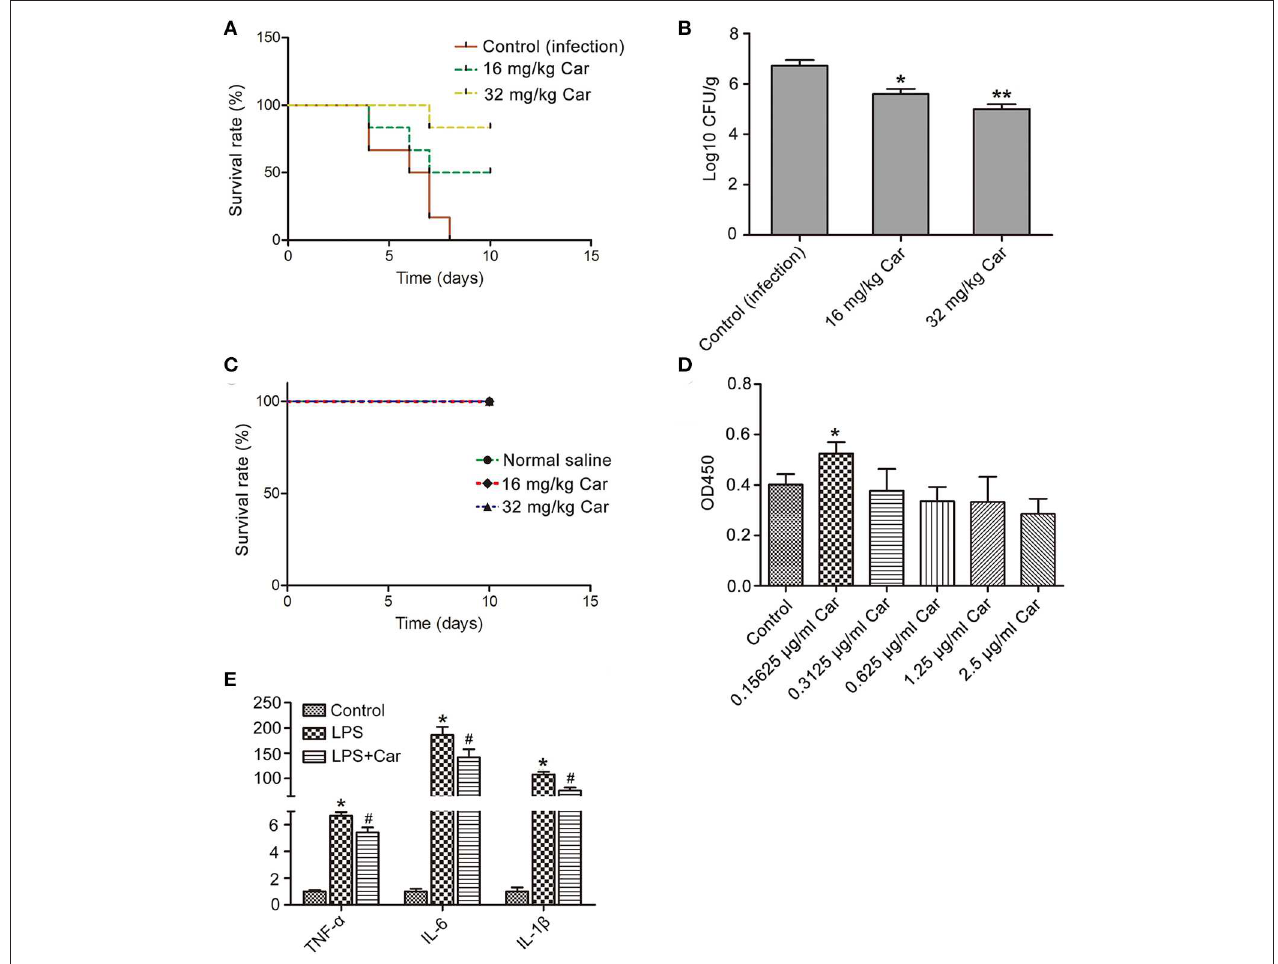
FIGURE 7 | Effects of carvacrol on systemic candidiasis and macrophage were analyzed. (A) Survival rate of infected mice was evaluated after treatment with carvacrol. (B) The fungal burdens in the kidneys were examined by plating dilutions onto YPD agar plates supplemented with streptomycin and ampicillin. * P < 0.05 and ** P < 0.01. (C) The toxicity of carvacrol on non-infected mice was observed for 10 days. (D) Effect of carvacrol on RAW264.7 macrophage viability was examined after treatment for 24h, and data were shown as mean ± SD ( n = 6). * P < 0.05. (E) The expression of pro-inflammatory cytokines, including TNF- α , IL-6, and IL-1 β , was determined in LPS-stimulated macrophages with or without carvacrol addition. Data were expressed as mean ± SD ( n = 3).* P < 0.05 vs. the control, and # P < 0.05 vs. LPS